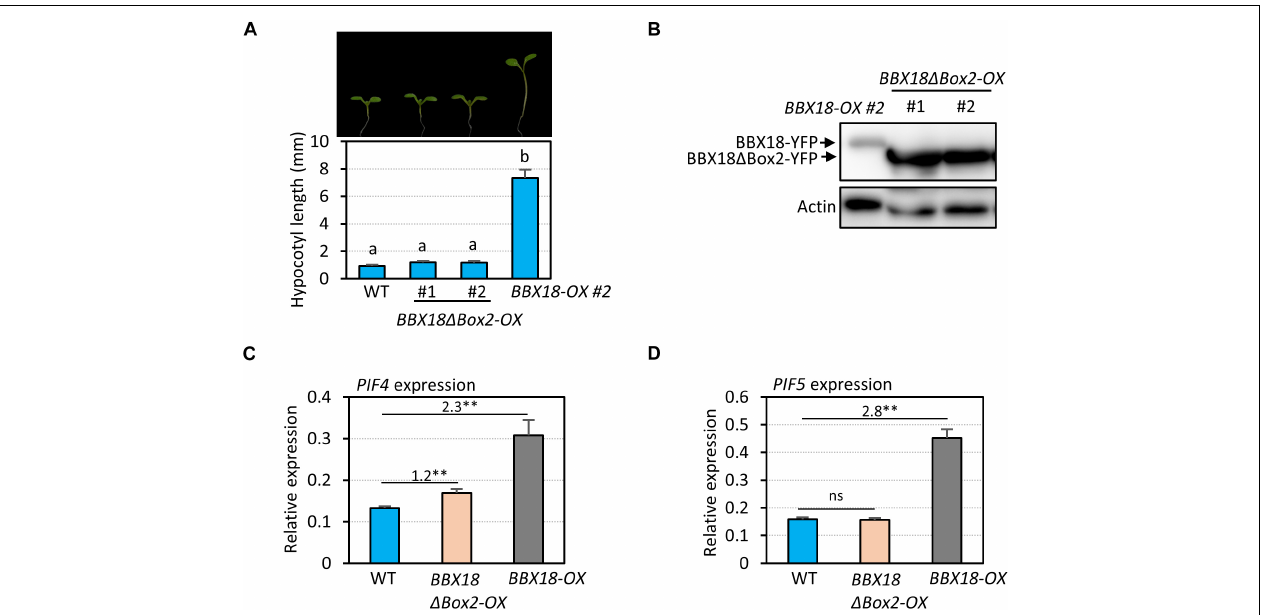
FIGURE 5 | B-Box2 domain is required for the hypocotyl growth promoting activity of BBX18. (A) Hypocotyl lengths of WT, BBX18 (cid:49) Box2-OX , and BBX18-OX seedlings grown under continuous white light at 20 ◦ C for 7 days. Letters above the bars indicate significant differences based on one-way ANOVA and Tukey’s test ( P < 0.05). Representative seedlings are shown in the upper panel. (B) Immunoblot analyses of BBX18 and BBX18 (cid:49) Box2 proteins. The plants were grown under white light constitutively at 20 ◦ C and harvested for total protein extraction. Immunoblotting was carried out using an anti-GFP antibody. Equal loading is demonstrated by Ponceau S staining. qRT–PCR analyses to check the expression of PIF4 (C) and PIF5 (D) . WT, BBX18 (cid:49) Box2-OX , and BBX18-OX plants were grown in 12 h light/12 h dark cycles (12L:12D) at 20 ◦ C for 4 days. On the 5th day, the plants were harvested at ZT12 for RNA extraction. The expression of target genes was normalized to that of PP2A . Error bars indicate SD ( n = 3). ** P < 0.01 (Student’s t -test). ns, not significant (Student’s t -test P ≥ 0.05). Numbers indicate the ratio of gene